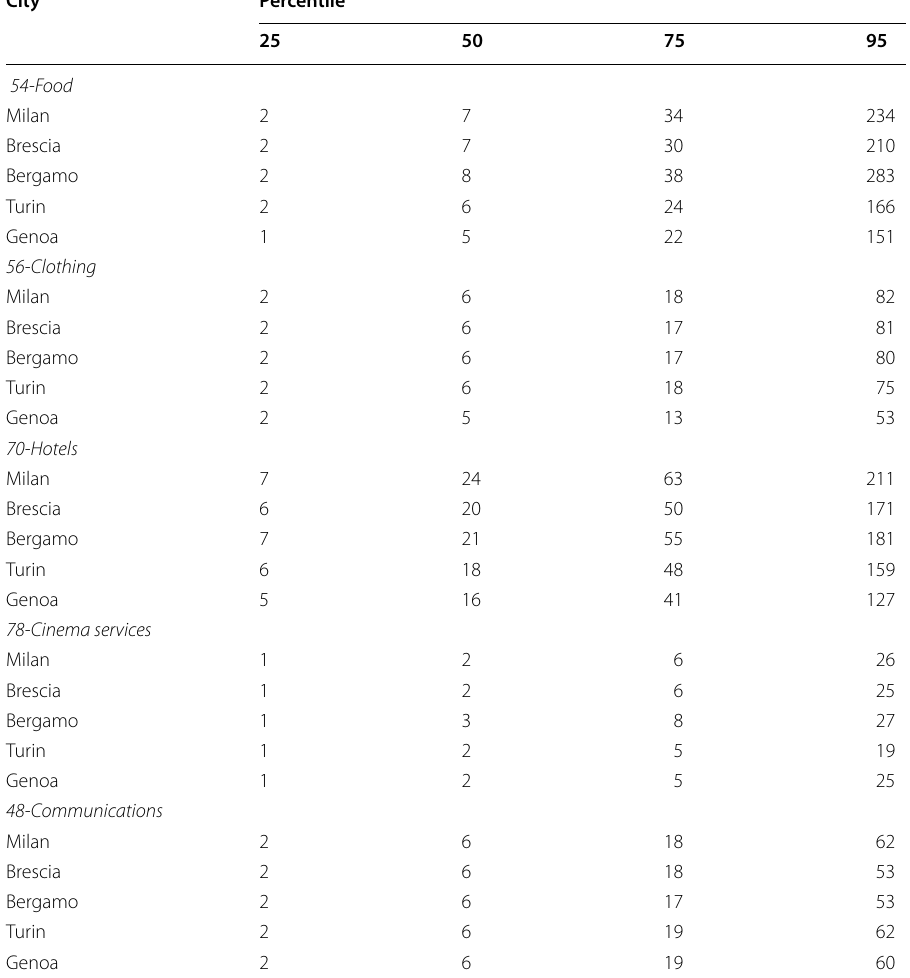
Table 2 Average spending